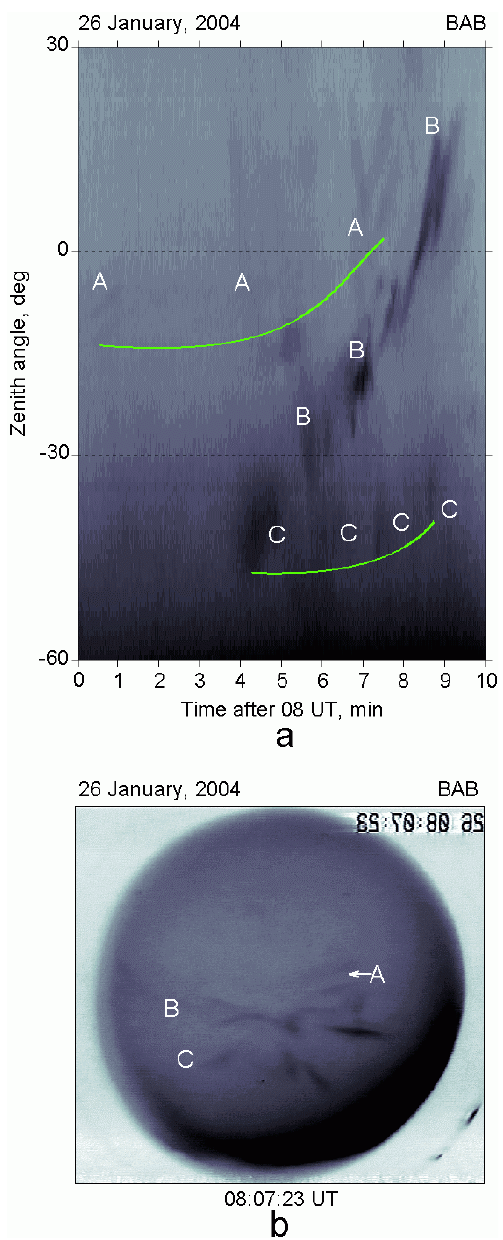
Fig.6. Response of arc system A, B and C to the positive Bz impulse: (a) keogram showing the arc dynamics and (b) arc system as seen by the TV camera in Barentsburg. The green line on the keogram highlights the trace of the movement of the lower edge of the arcs A and C.